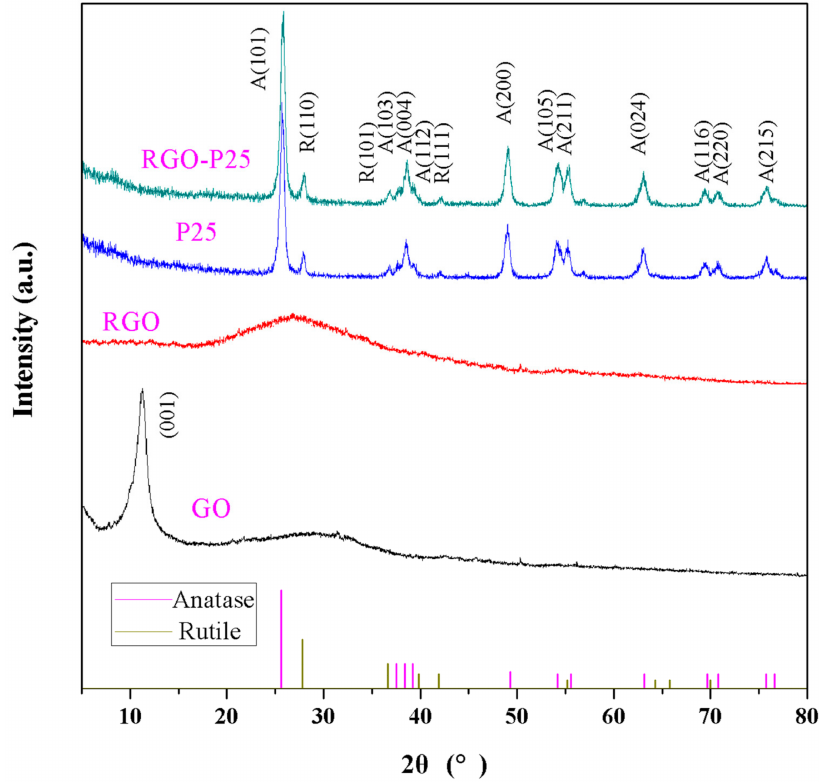
Figure 2. The XRD patterns of the different catalysts.